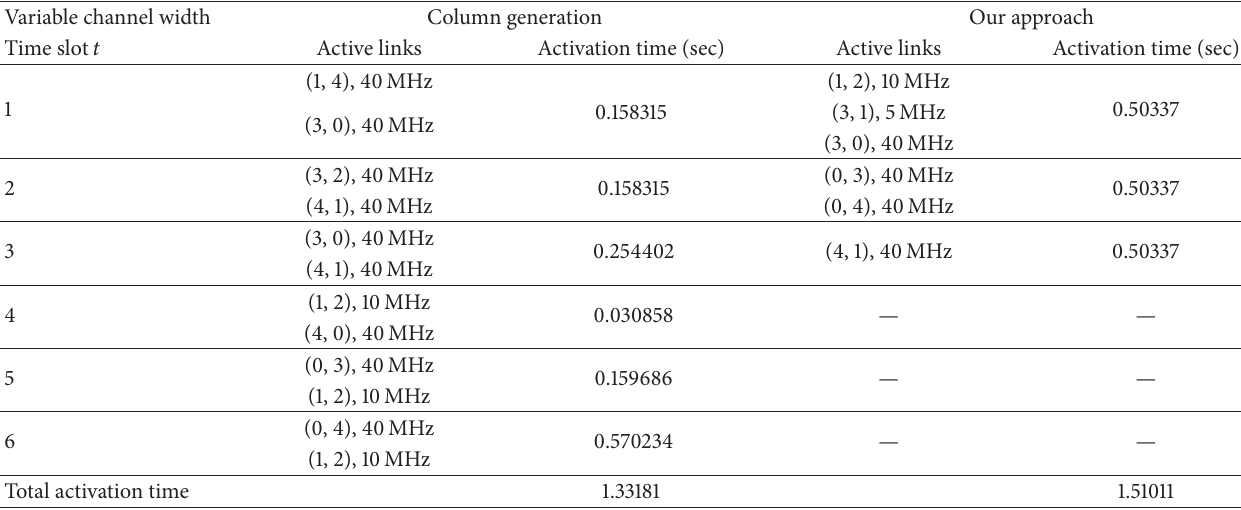
Table 4: Result of variable-width channel allocation.